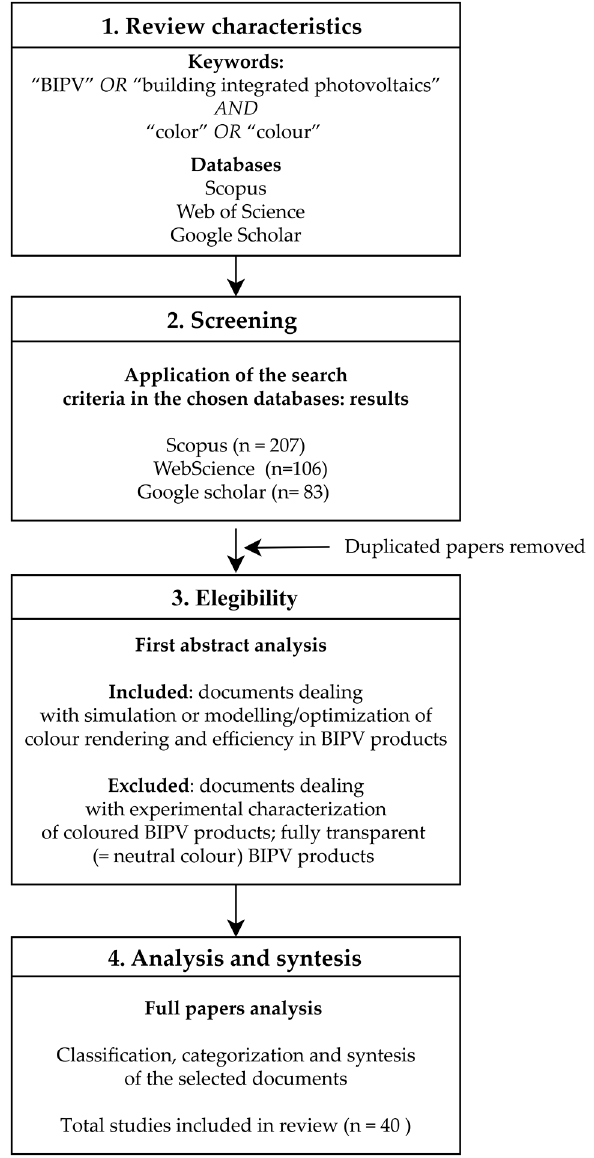
Figure 1. Review approach and structure.